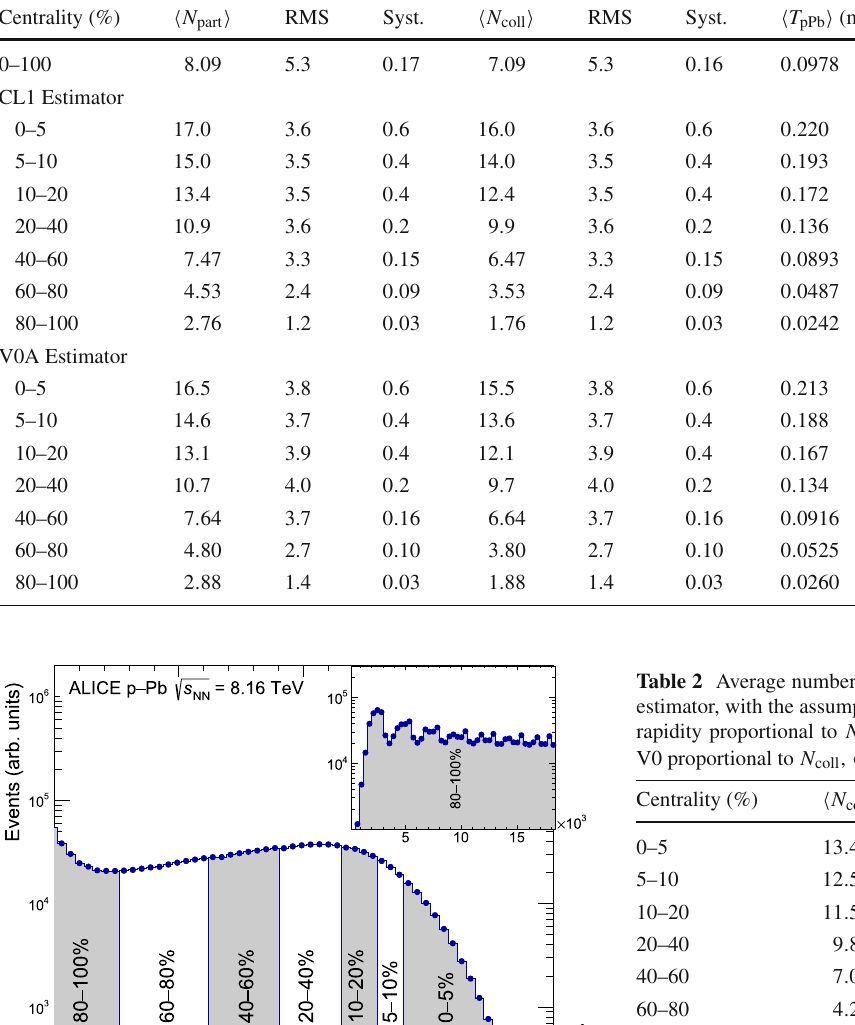
Table 1 Mean values of N part , N coll and T pPb of p–Pb collisions for MB and centrality classes defined by slices in CL1 and V0A. The values are obtained with a Glauber Monte Carlo calculation coupled to an NBD to fit CL1 and V0A distributions